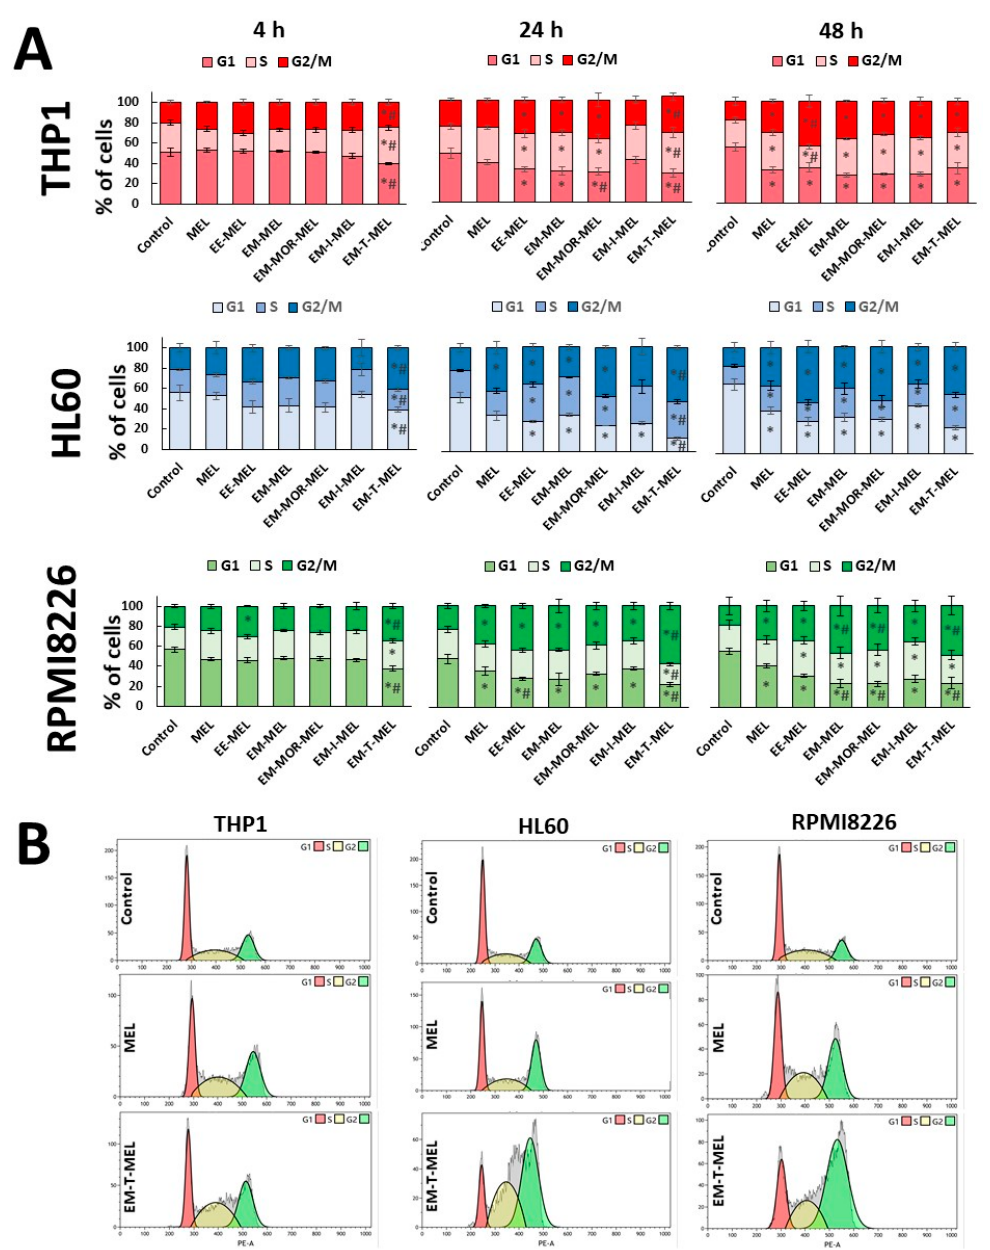
Figure 4. Melphalan and its derivatives induced cell cycle arrest. HL60, THP1, and RPMI8226 cells were incubated for 4, 24, and 48 h with MEL, EE-MEL, EM-MEL, EM-MOR-MEL, EM-I-MEL, and EM-T-MEL. ( A ) Distribution of the cell cycle phases. All data are from three biological assays and are graphed as the mean ± SD. (*) Statistically significant differences compared to the control cells, p < 0.05. (#) Statistically significant differences compared to unmodified MEL, p < 0.05. ( B ) Representative histograms of cell cycle analysis. Treatment with EM-T-MEL significantly ( p < 0.05) changed the distribution of the cell cycle compared to the untreated cells. Compared with the unmodified drug, the